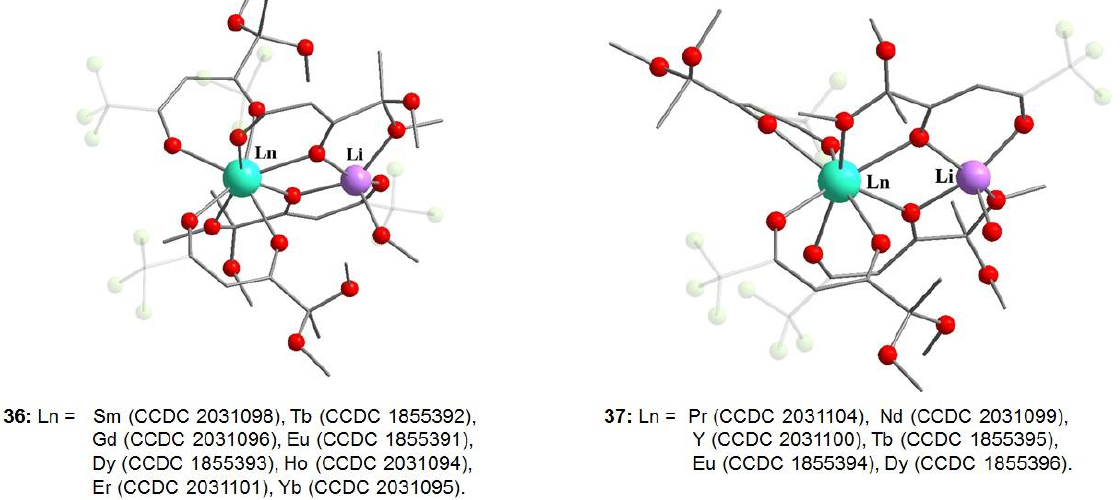
Figure 18. Molecular structures of 36 and 37 ( dik = L 10 ) [86,88]. Hydrogen atoms have been omitted, CF 3 groups are transparent for clarity. The cif has been retrieved from CCDC.